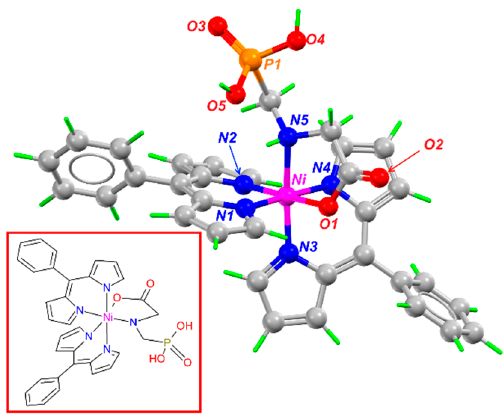
Figure 6. Optimized structure of the (NiGlyp(PhDP) 2 ) complex.